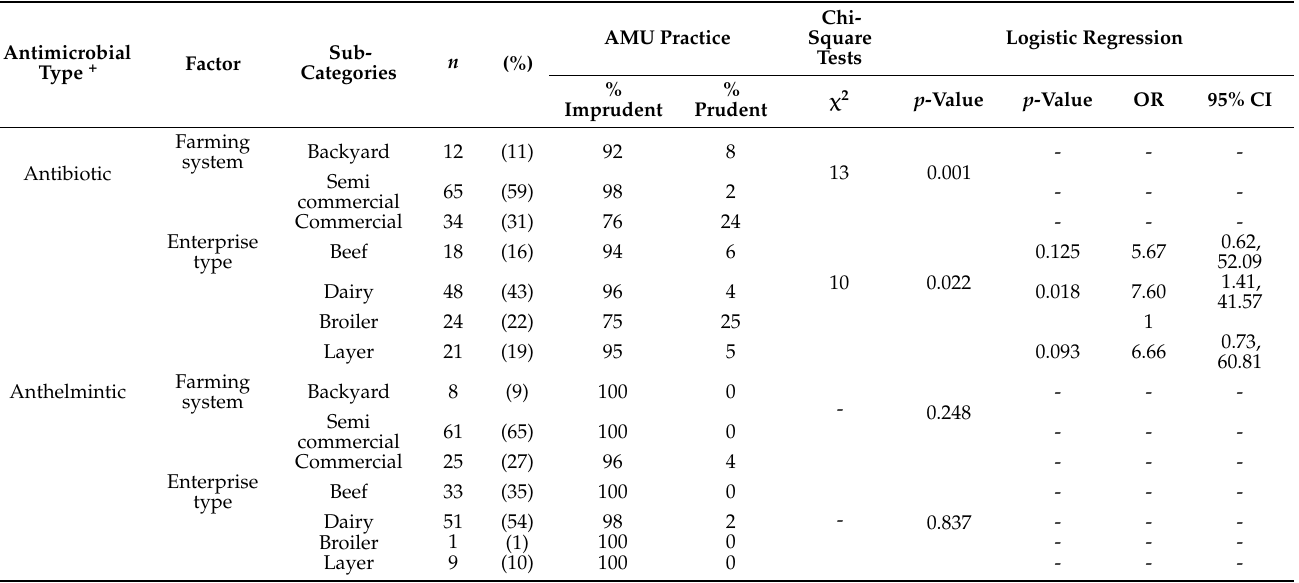
Table 4. Summary of association and logistic regression modelling of farming systems and enterprise types with antimicrobial use practice on livestock farms located in Central and Western divisions of Viti Levu,